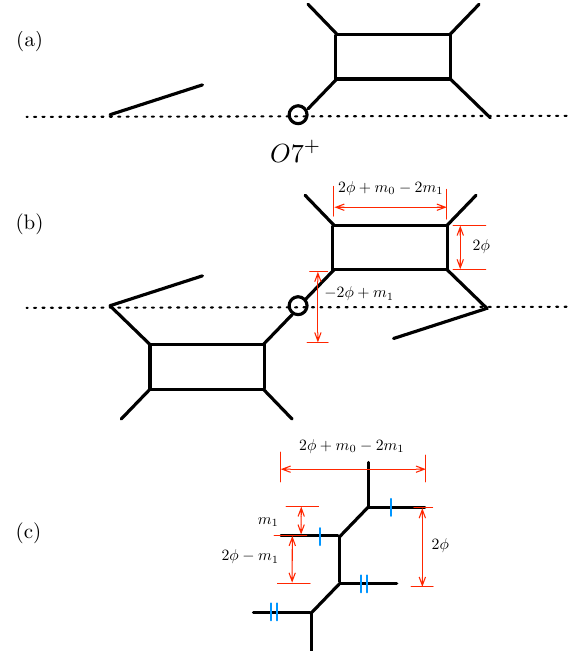
Figure 10. (a) A 5-brane web for SU(2) 0 + 1 Adj . (b) The reflected image of (a) is included. (c) A 5-brane configuration for the